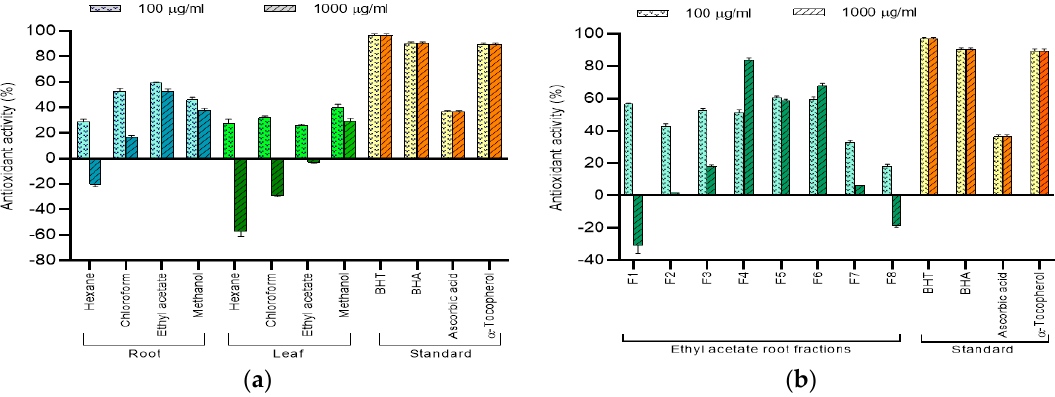
Figure 4. Antioxidant activity of C. vespertilionis ( a ) crude extract and ( b ) fractions evaluated by β -carotene lipid peroxidation assay at 100 and 1000 μ g/mL.